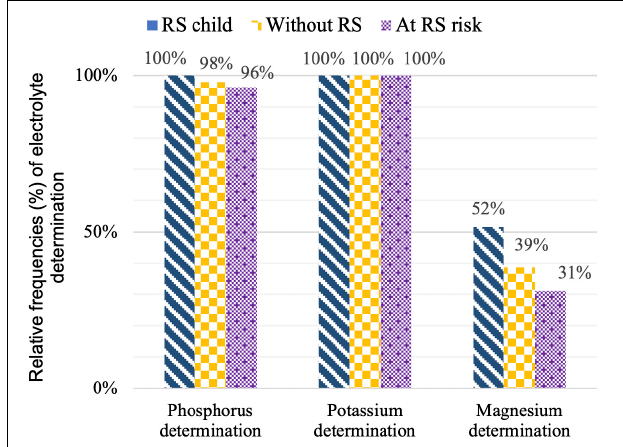
FIGURE 4 | Relative frequencies (%) of electrolyte determination within the children with probable Refeeding Syndrome (“RS child”), these without Refeeding Syndrome (“without RS”) and these at Refeeding Syndrome Risk (“at RS risk”).